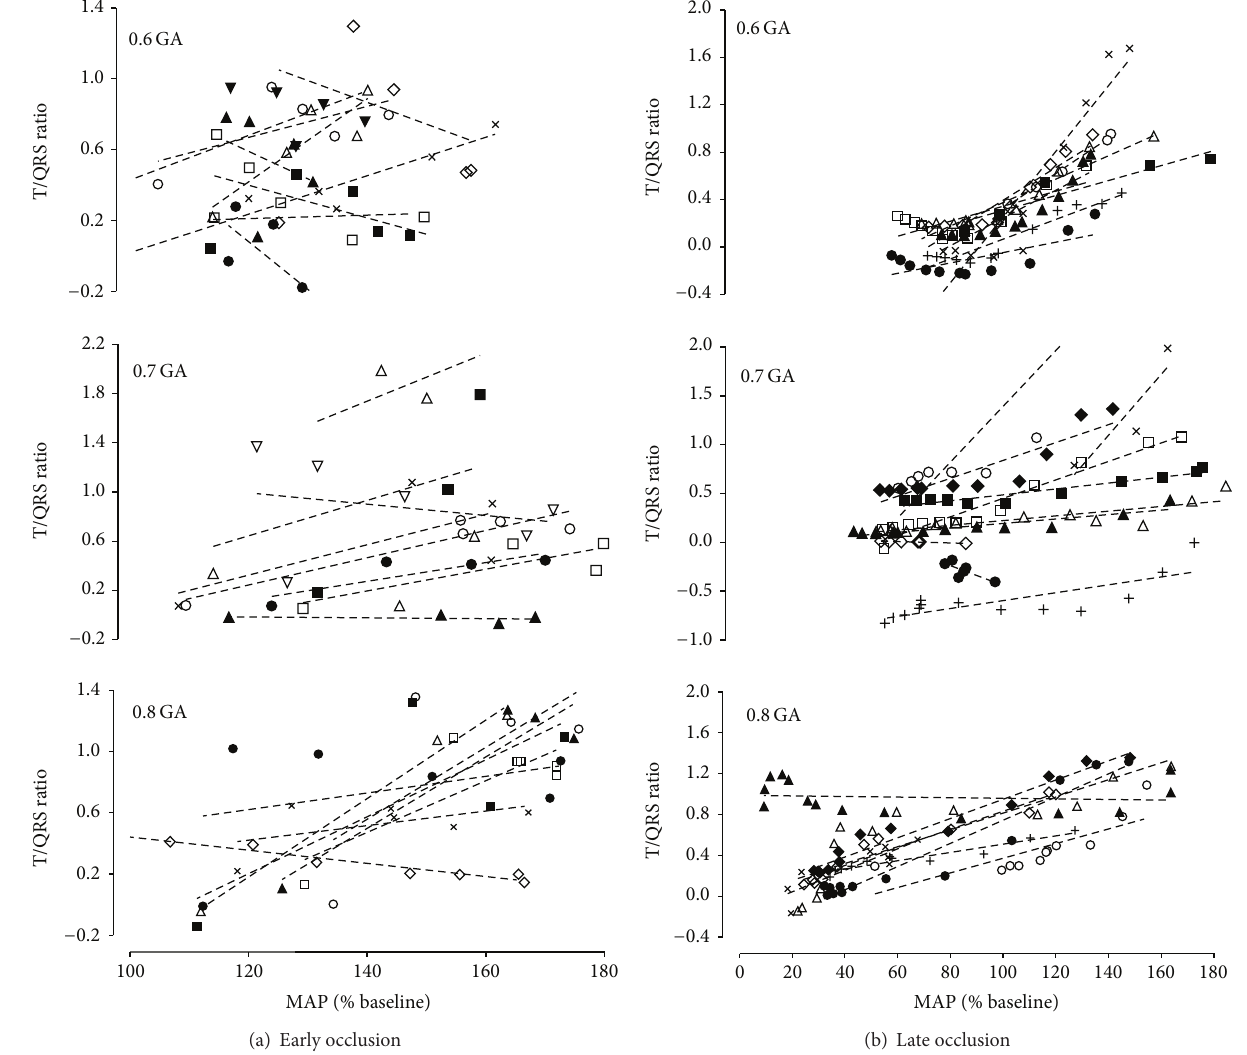
Figure 4: The relationship between changes in mean arterial pressure (MAP, % baseline) and T/QRS ratio in 0.6 gestation (0.6 GA), 0.7 gestation (0.7 GA), and 0.8 gestation (0.8 GA) fetuses. (a) shows the within-subjects relationship changes from the start of occlusion until the peak T/QRS ratio; the period when most important fetal cardiovascular adaptations take place (0.6 GA: N.S., 𝑛 = 9 ; 0.7 GA: N.S., 𝑛 = 8 ; 0.8 GA: 𝑃 < 0.05 , R 2 = 0.38, 𝑛 = 8 ). (b) shows the within-subjects relationship changes from the peak T/QRS ratio until 15 minutes of occlusion; the period during which most of the fetal decompensation occurs ( 𝑃 < 0.01 , R 2 = 0.67, 𝑛 = 27 ). There was no significant effect of gestational age. Different symbols represent individual animals, while the dotted lines indicate the within-subject regression relationship. Seven of 25 fetuses did not have a positive relationship between MAP and T/QRS ratio during the early phase of